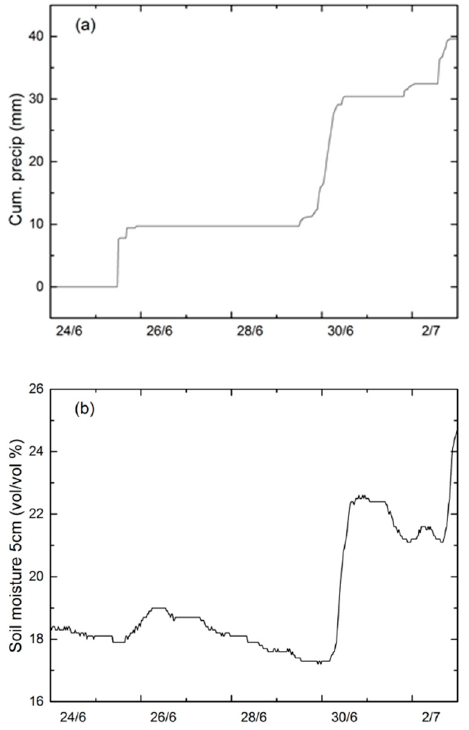
Figure 4. ( a ) Cumulative precipitation and ( b ) half-hourly soil moisture at 5-cm depth for the period 24 June–2 July 2014.